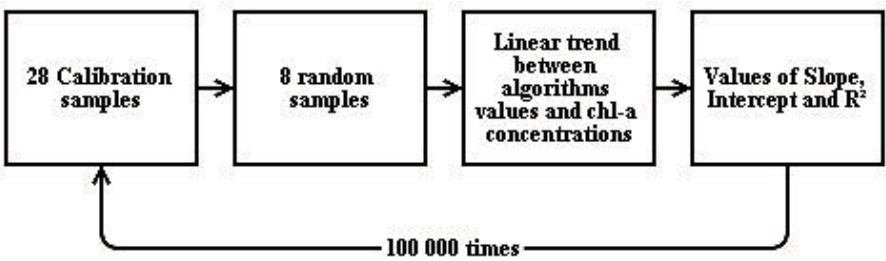
Figure 3. Scheme of Monte Carlo simulation to calibrate the models.